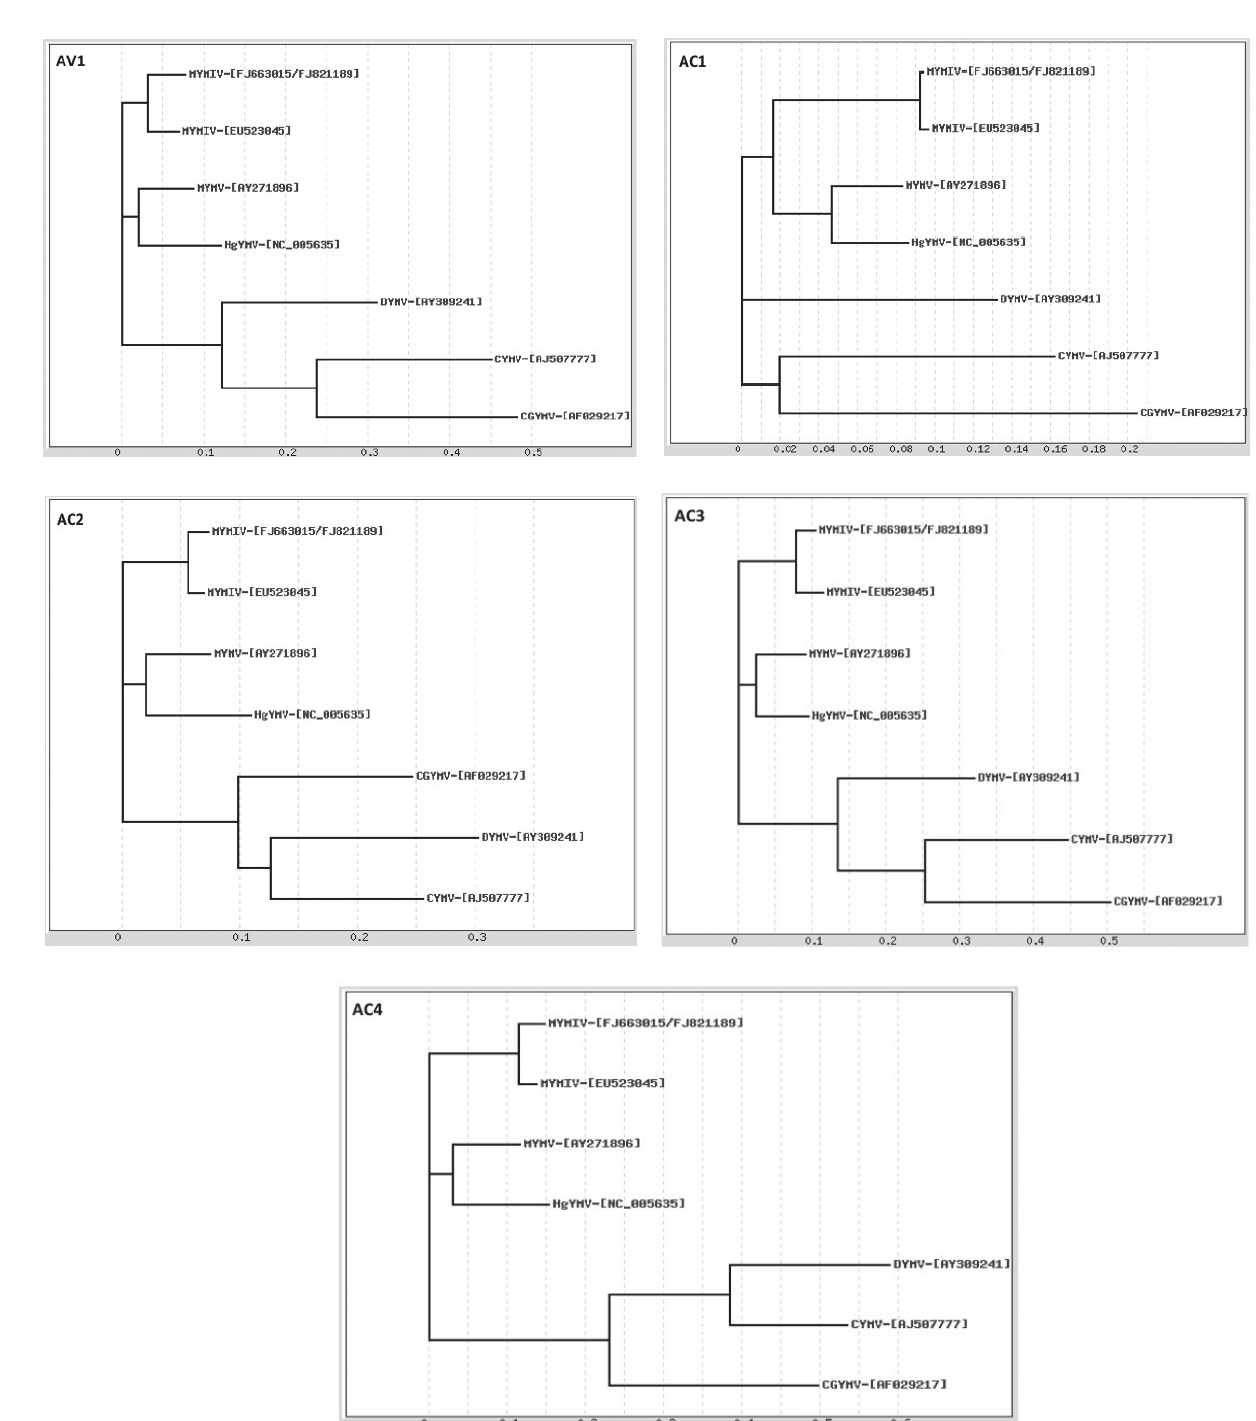
Figure 3. Cluster phylogram illustrating the phylogenetic relationship based on the multiple alignments of the de- duced amino acid sequences of genes AV1, AC1, AC2, AC3 and AC4 of the MYMIV isolate under study with the cor- responding genes of some known